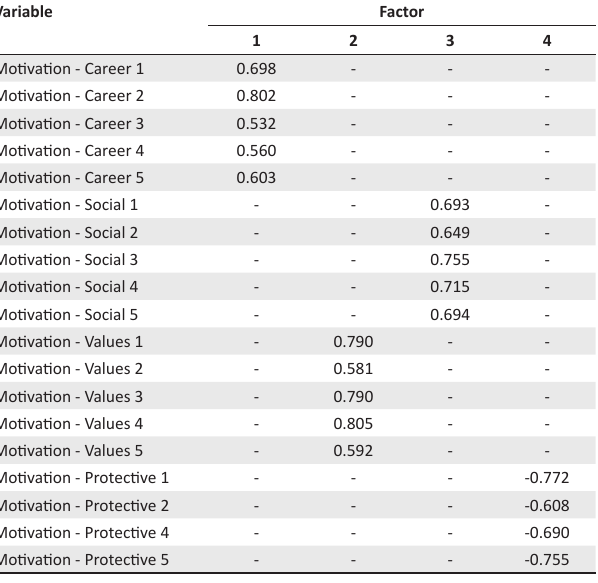
TABLE 2: Factors for motivation items.